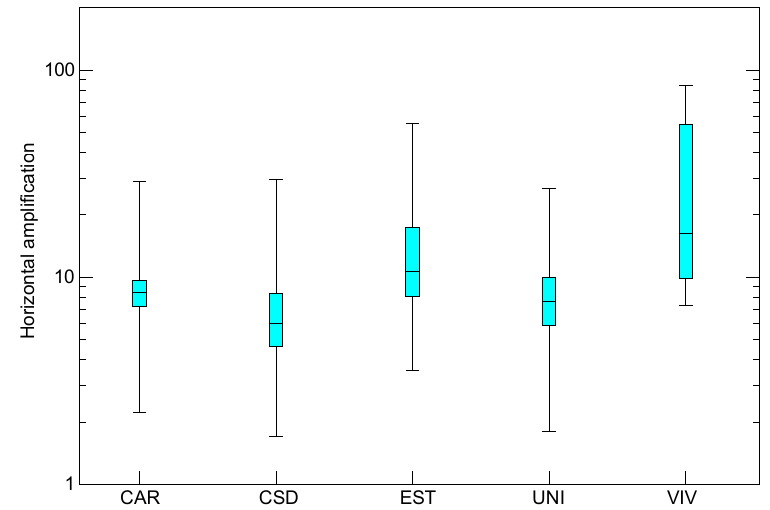
Figure 11. Horizontal amplification at each of the five sites where aftershocks were recorded, obtained from the different methods used to estimate site response. The limits of the box show the lower and upper quartiles, the whiskers indicate the lower and upper extreme values, and the line inside the box indicates the median value.